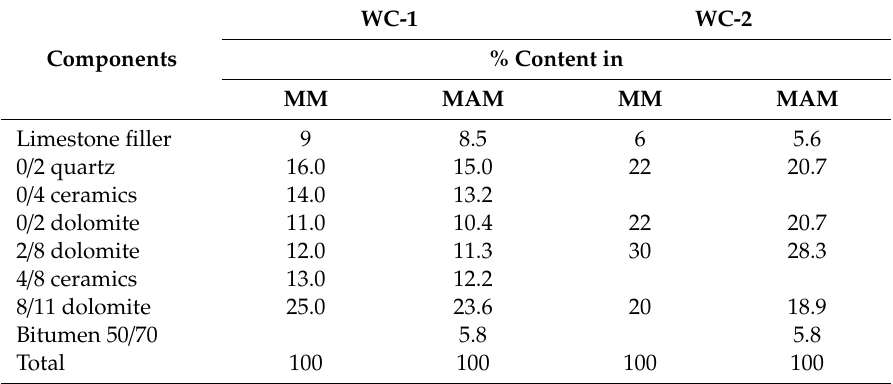
Table 4. Compositions of the mineral mixture (MM) and mineral–asphalt mixture